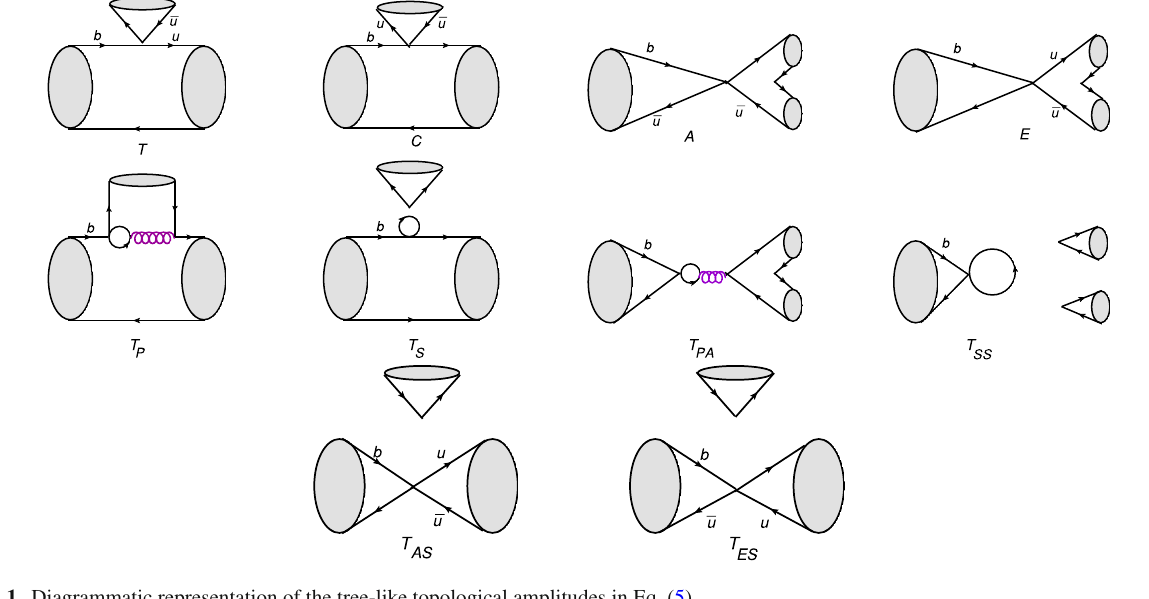
Fig. 1 Diagrammatic representation of the tree-like topological amplitudes in Eq.